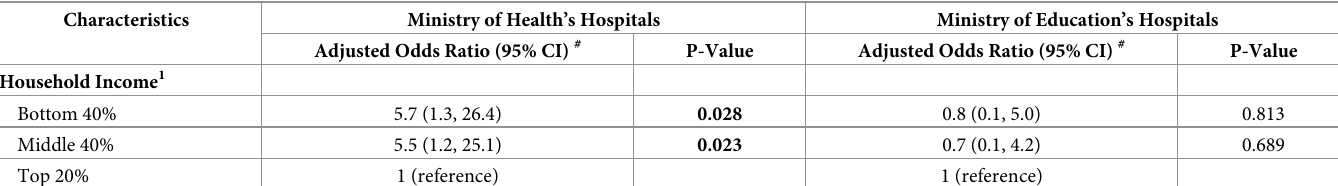
Table 5. Association between levels of household income and prevalent odds of catastrophic health expenditure by a healthcare provider.